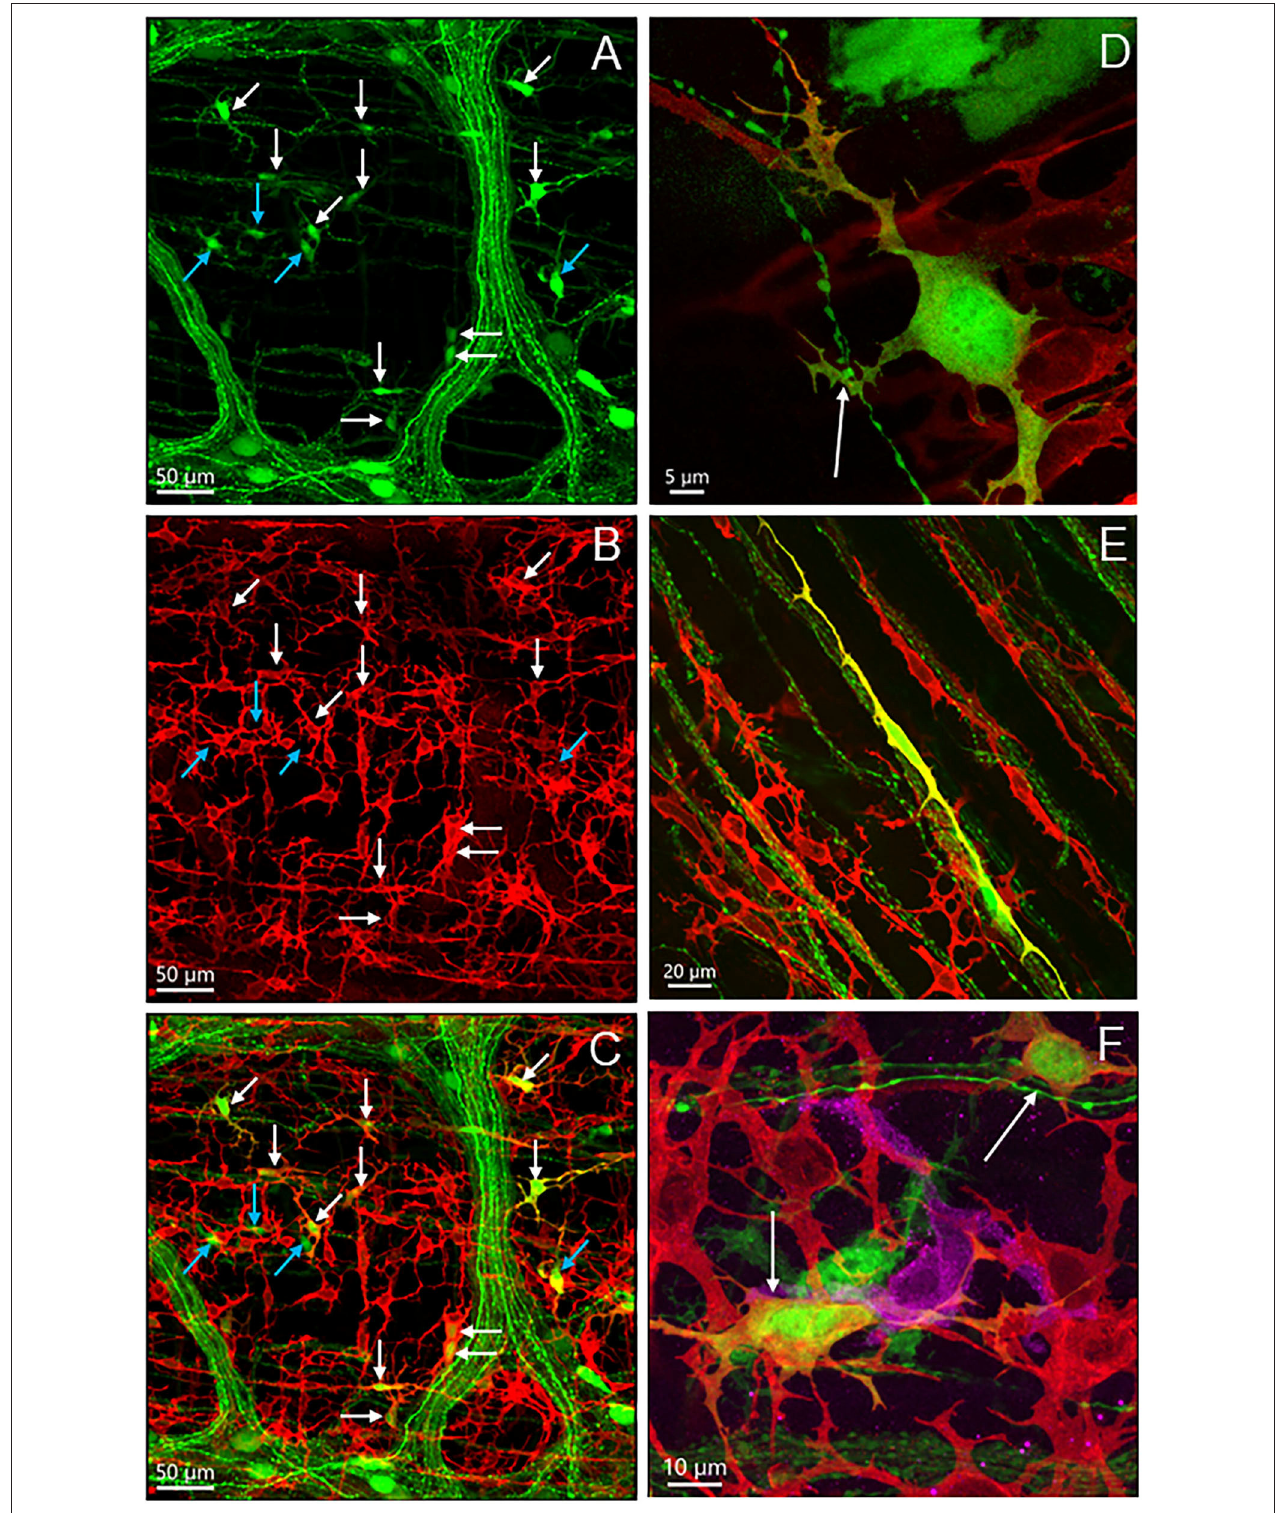
FIGURE 9 | Photomicrographs of c-Kit-ir cells transduced by iv AAV9. (A–C) The same photo displayed by separate fluorescence of AAV9 (green) and c-Kit (red), and dual labeling of an area with many AAV9 + c-Kit-ir cells (white arrows). Some AAV9-transduced cells with similar morphology were not c-Kit-ir (blue arrows). (D) Processes of an AAV9 + c-Kit cell closely adjacent to a varicose axon (arrow). (E) A long slender dual labeled cells in the circular muscle layer. (F) Close proximity of an Iba1-ir macrophage cell (magenta), AAV9 + c-kit cells (arrows), and an AAV9 cell in the net of c-kit ICC cells near myenteric plexus.